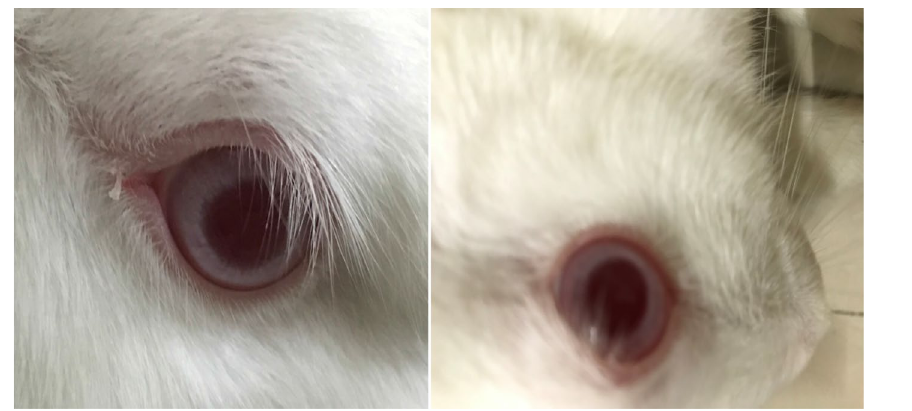
Figure3. Before and after instillation of test